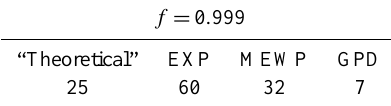
Table 4. Number of exceedances of the local millennial quantile for the three models (EXP, MEWP, GPD) computed on the 478 rain gauges. Left columns shows the “theoretical” number of ex- ceedances